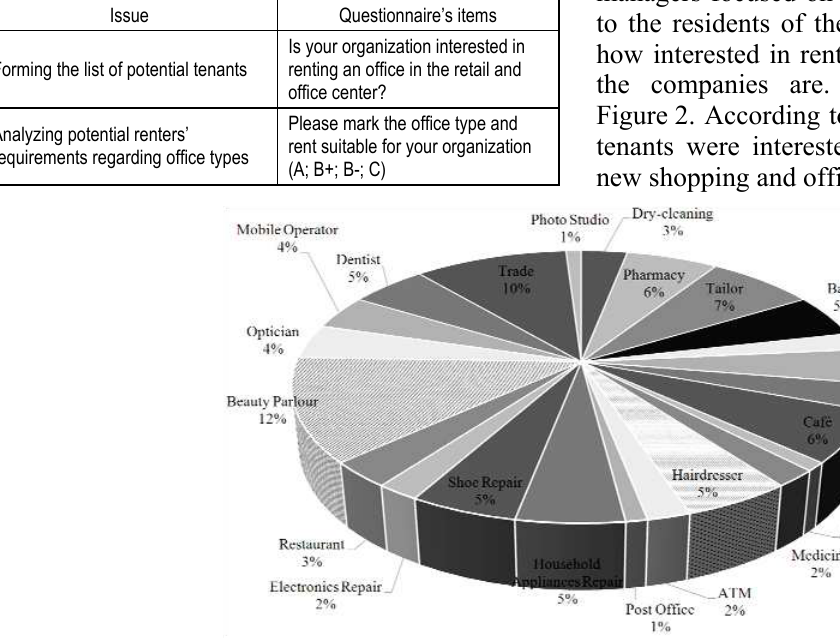
Fig. 2. Structure of the surveyed organizations by business